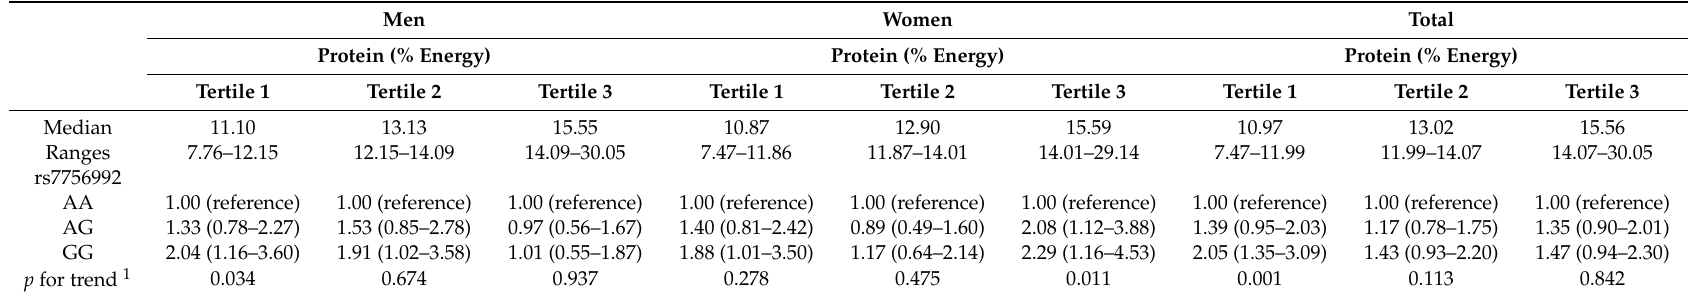
Table 3. SNP in the CDKAL1 gene and risk of diabetes by tertile of dietary protein (% energy) in Korean adults.